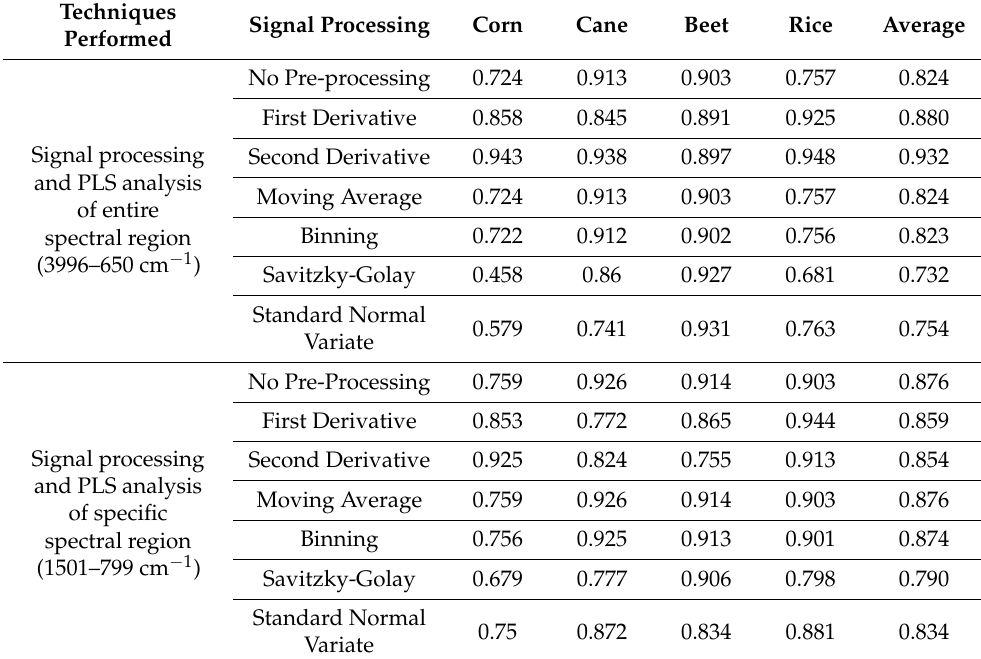
Table 2. R 2 values for the four syrup training set data indicating the goodness-of-fit measure for the predictive models (PLS = partial least